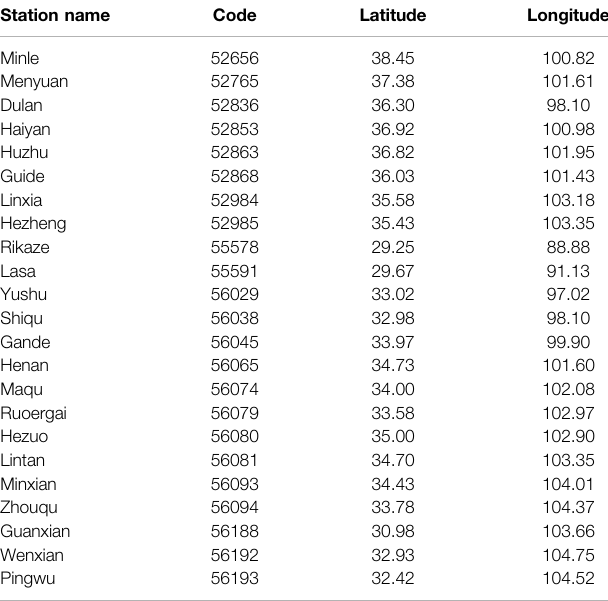
TABLE 1 | Summary of ground phenological observation sites in